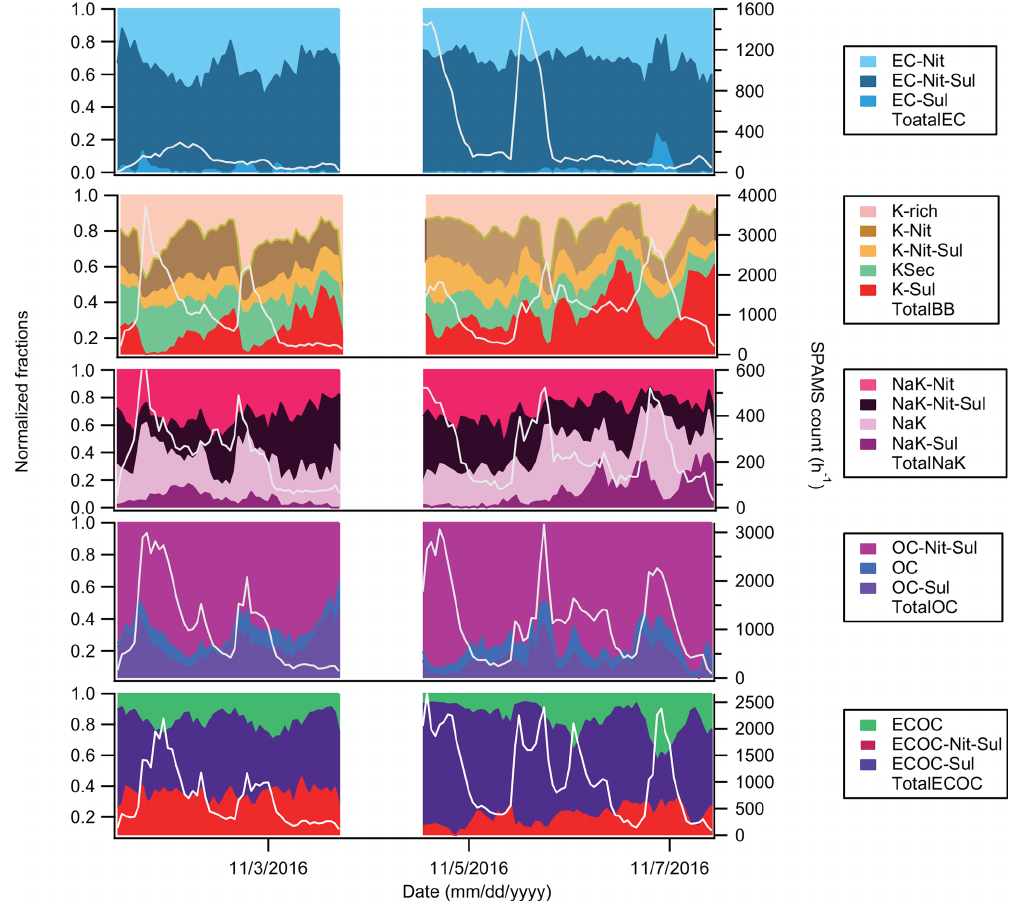
Figure 8. Time trends of number fractions of particle types (left) and hourly counts of particle families (EC, BB, NaK, OC, and ECOC; right) during Pollution Event 1 (E1; 1–8 November) at